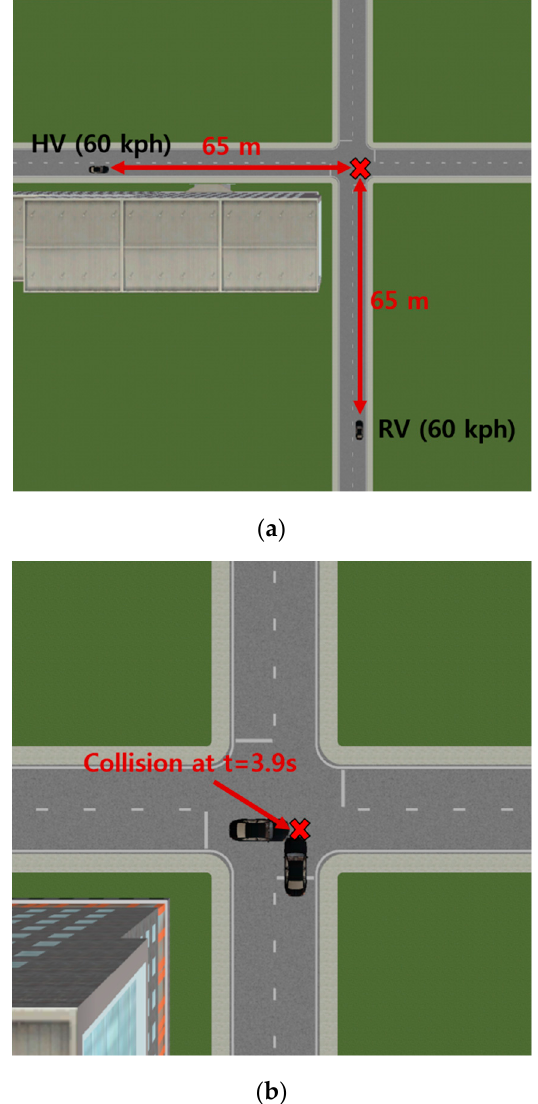
Figure 7. The simulation environment for the vehicle–vehicle collision scenario. ( a ) Experiment setup at the start of the simulation; ( b ) collision between the host and the remote vehicle at the end of the simulation.